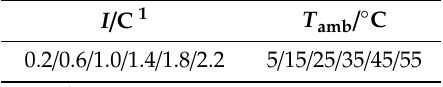
Table 2. Specific value of experiment I and T amb